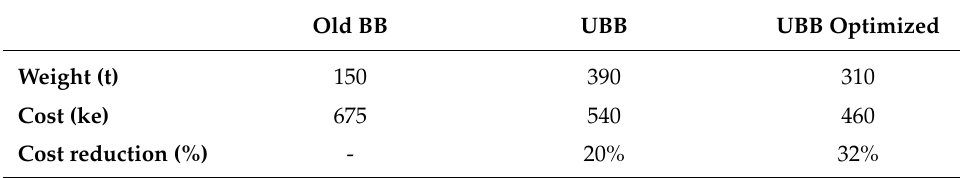
Table 12. Cost reduction for the different buoyancy bodies of the GICON ®